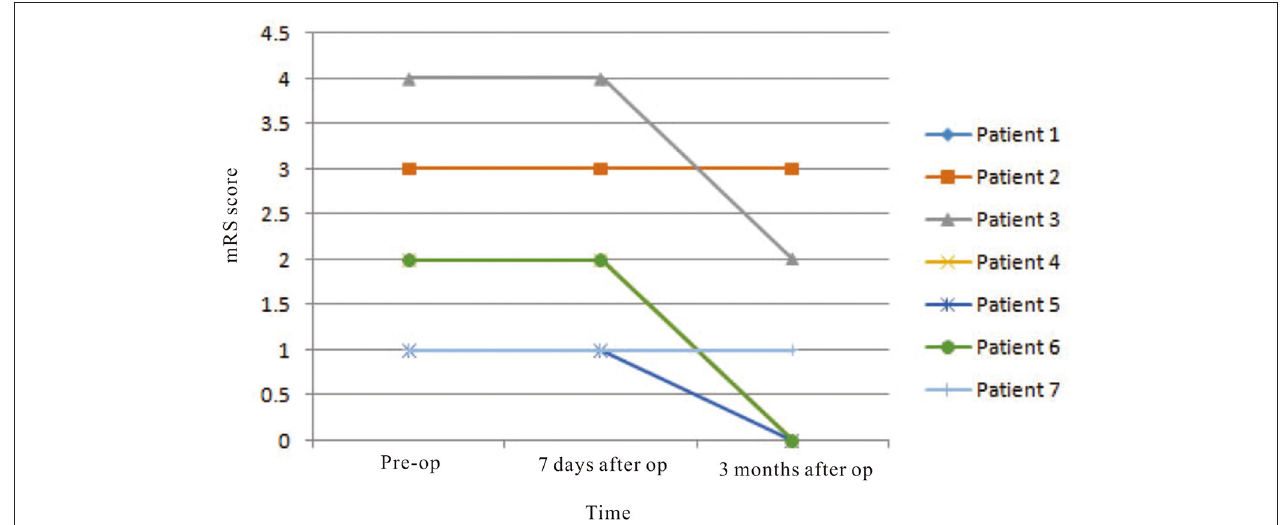
FIGURE 4 | The mRS scores were improved significantly according to statistical analysis ( p = 0.012).